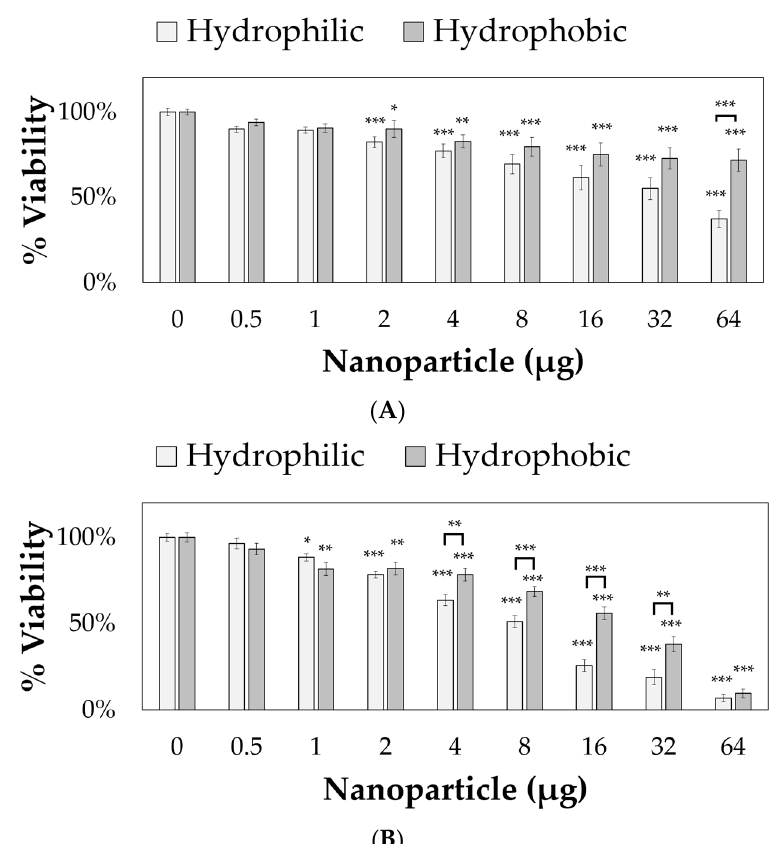
Figure 5. Hydrophilic and hydrophobic nanoparticle cytotoxicity after 24 h incubation with ( A ) PC12 cells and ( B ) ReNcell VM (RVM) cells. Error bars depicted as standard error. * p < 0.05, ** p < 0.01, *** p < 0.001.